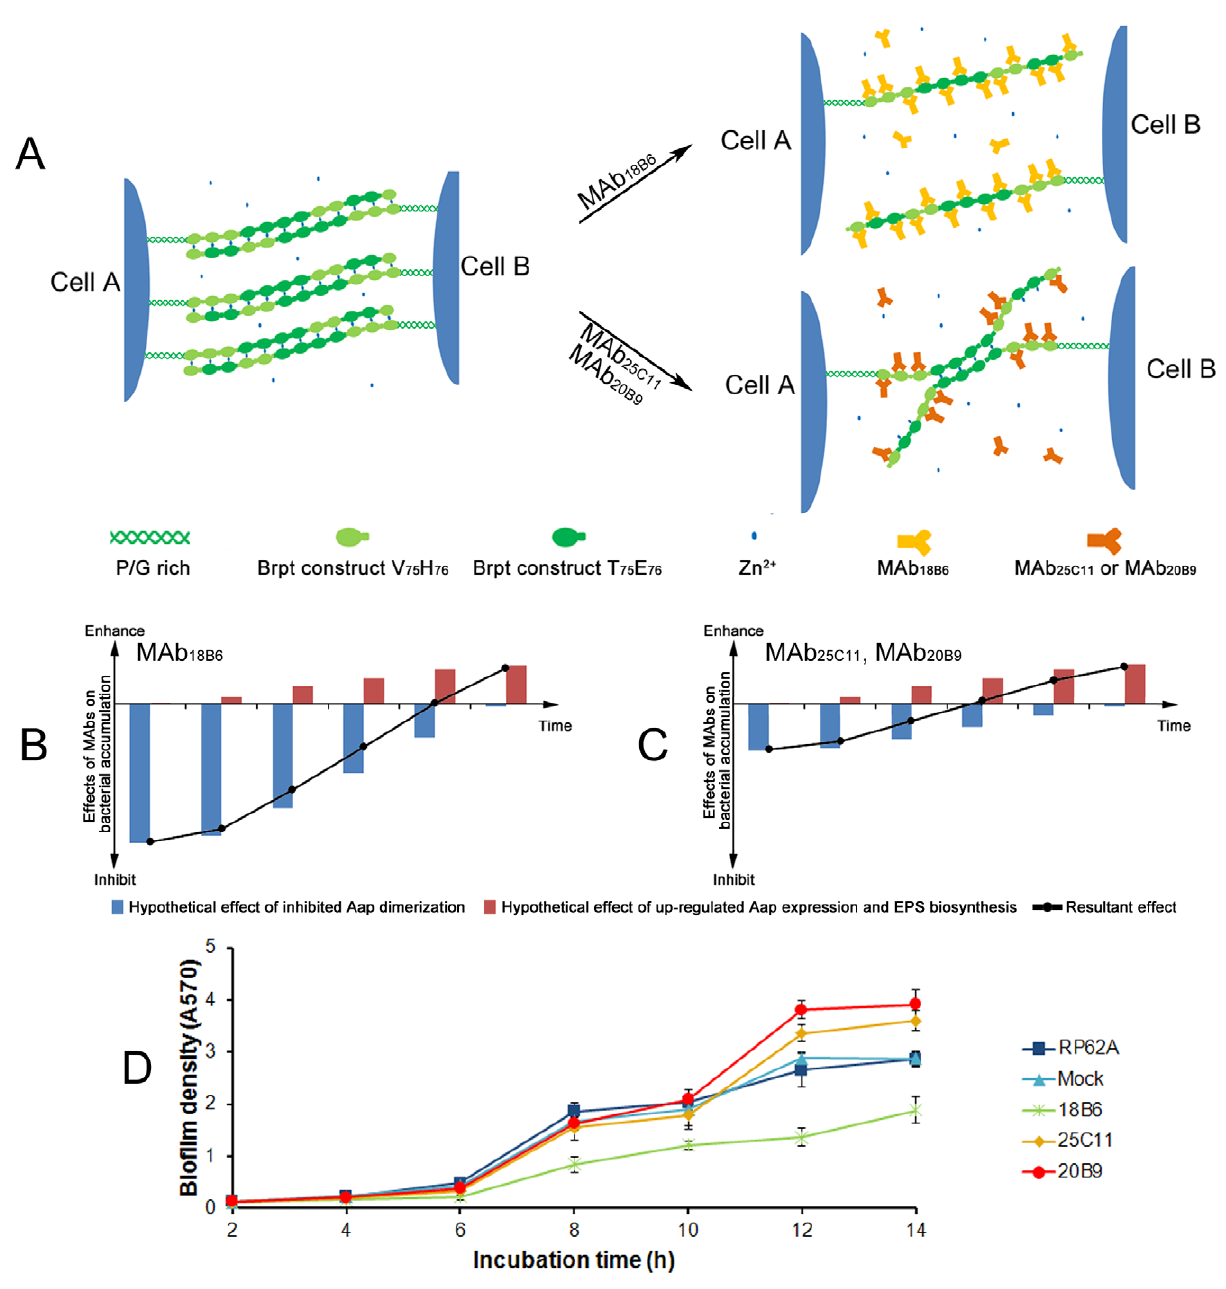
Figure 10. Contradictory actions of the MAbs on biofilm formation. (A) Model for MAbs affecting Aap dimerization. According to the zinc zipper model for intercellular adhesion mediated by zinc-dependent Aap dimerization [22], we speculate that MAb 18B6 binds to all twelve AapBrpt constructs and significantly inhibits Aap dimerization, whereas MAb 25C11 and MAb 20B9 bind to six of the AapBrpt constructs and block Aap dimerization incompletely. (B, C) Model for MAbs affecting bacterial accumulation. The resultant effect (black curves) of the MAbs on bacterial accumulation is attributed to the counteraction between two contradictory actions, one inhibits biofilm formation by binding to Aap (blue bars), and the other enhances bacterial accumulation by up-regulating Aap expression and EPS biosynthesis (red bars). (D) Kinetic studies on biofilm formation. The cells of S. epidermidis RP62A were co-cultured with 10 m g/mL of each MAb in 96-well polystyrene plates initially at 4 u C for 2 h, and then at 37 u C for 2 h, 4 h, 6 h, 8 h, 10 h, 12 h, and 14 h, respectively. After incubation, biofilm formation at different time points was measured using crystal violet staining, and the results are depicted as means 6 SD of three independent experiments. doi:10.1371/journal.pone.0020918.g010 observed under a confocal laser scanning microscopy (TCS SP5 (Takara, http://www.takara-bio.com) for 14 h, and then washed CLSM, Leica, http://www.leica-microsystems.com). with PBS, fixed with methanol, and stained with 2% (wt/vol) crystal violet. For disintegrating treatment of the bacterial clusters, Disintegrating treatment of the biofilms and the bacterial cell the clusters were treated with 0.1 mg/mL proteinase K (Merck, clusters were tested as published elsewhere [17,27,39,40]. The biofilms were formed in the presence of 0.14 U/ m L DNase I http://www.merck.com), 20 mM Tris (pH 7.5), 100 mM NaCl